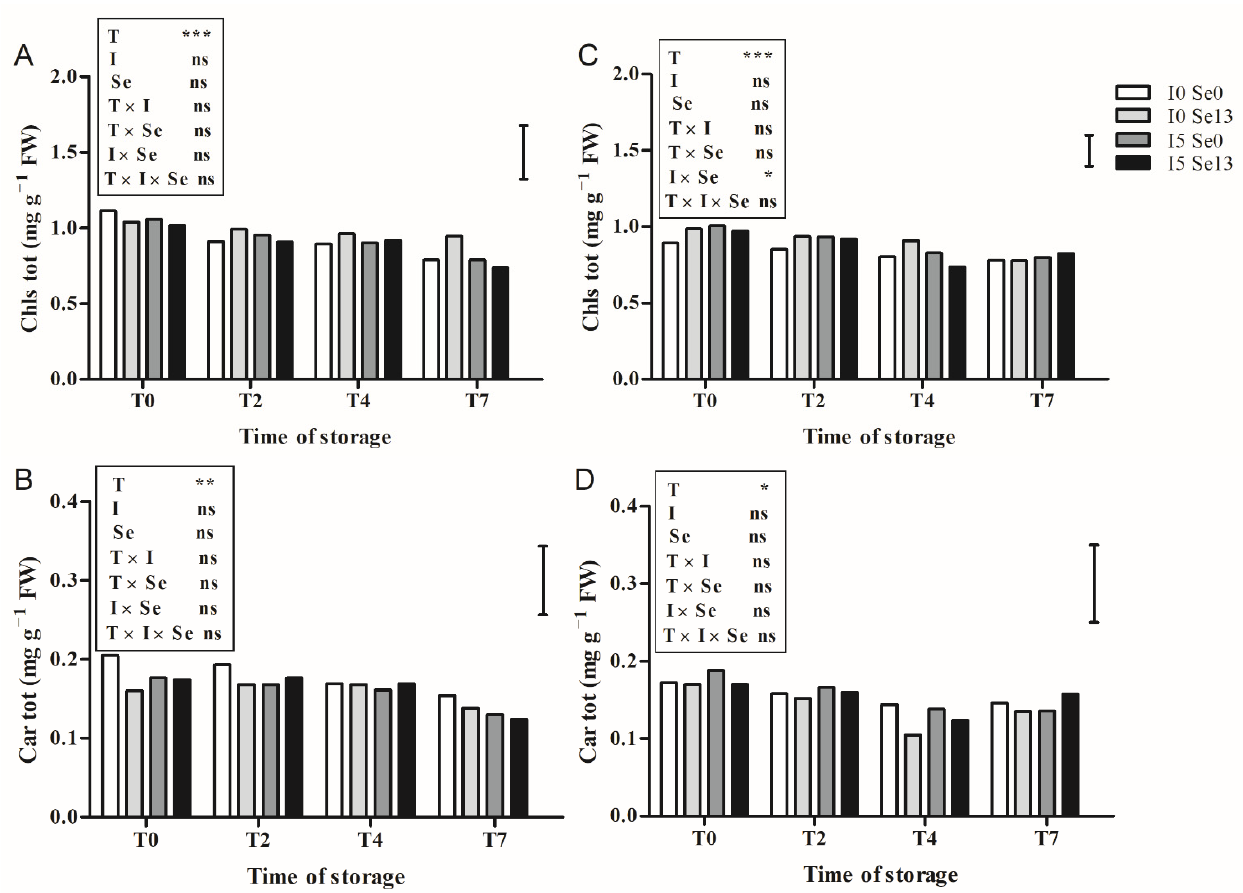
Figure 1. Total chlorophyll, FS ( A ) and AE ( C ), and carotenoid, FS ( B ) and AE ( D ), contents measured after 2 (T2), 4 (T4), and 7 (T7) days of storage in leaves of lettuce plants grown at different concentrations of I (0 and 5 µ M) and Se (0 and 13 µ M) in the nutrient solution, in the second experiment. Values are means of the 3 replicates. Significance level: *** p ≤ 0.001; ** p ≤ 0.01; * p ≤ 0.05; ns = not significant. Bar indicates LSD value.